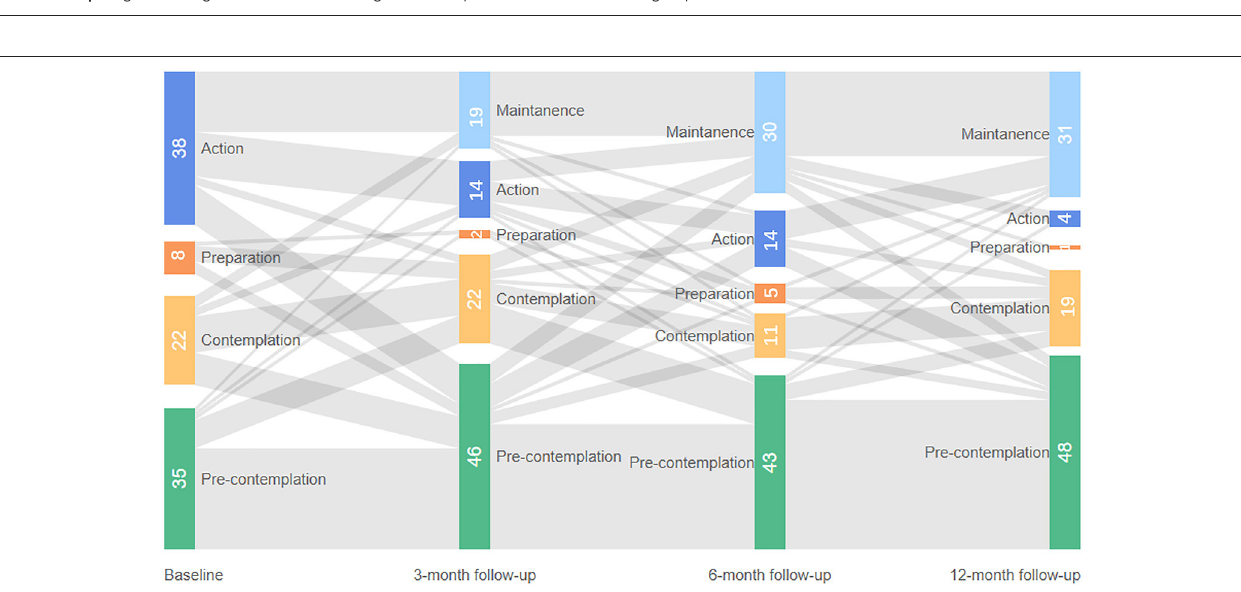
FIGURE 4 | Stage of change for medication taking at all time points in the control